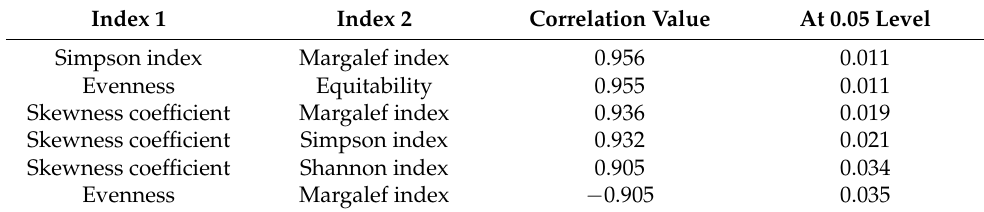
Table 3. Correlation statistics of the diameter inequality and diversity measures in the Hilltop stand of the Omo Forest Reserve.